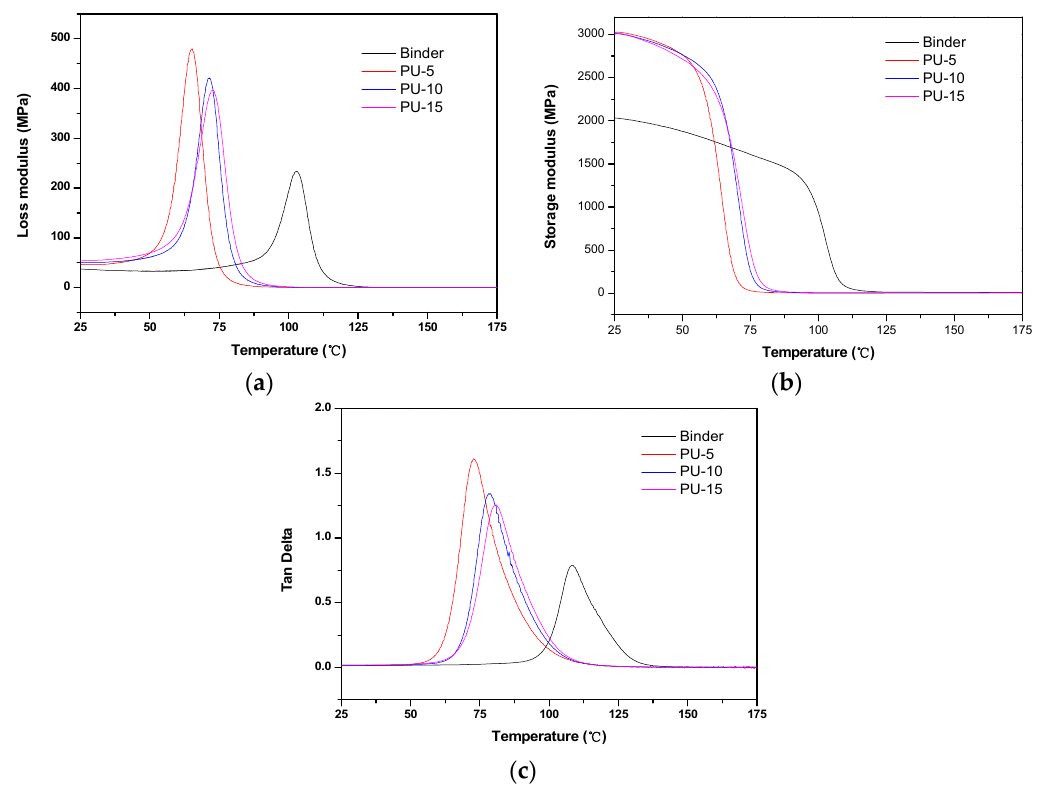
Figure 7. DMA data of the cured epoxy polymers: ( a ) storage modulus, ( b ) loss modulus, and ( c ) tan δ . 3.4. FE-SEM and TEM Images of the Fractured Epoxy Polymers Obtained after Impact